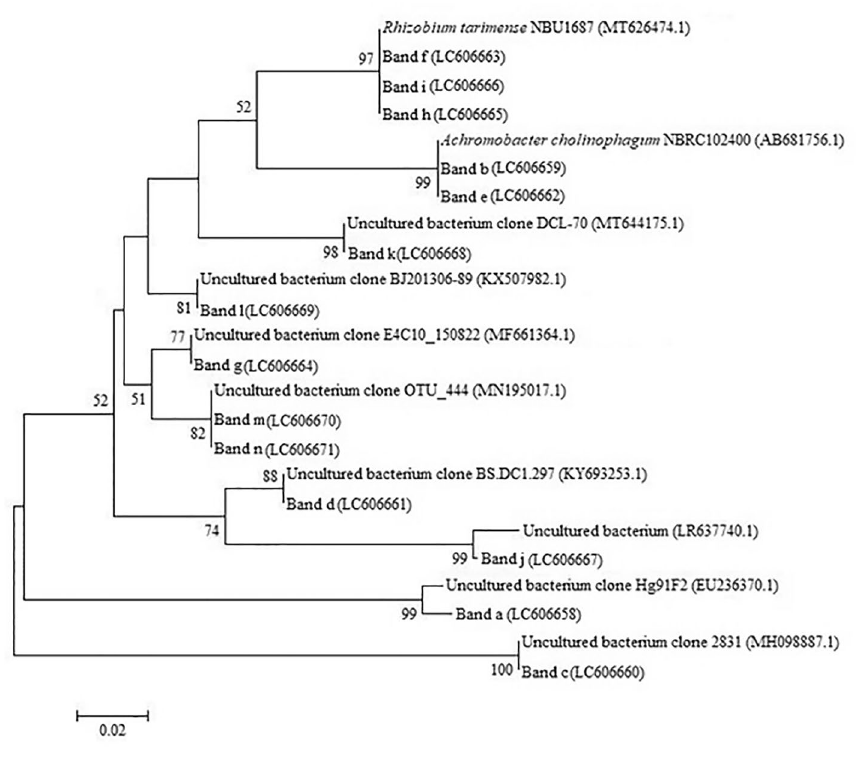
Figure 5. The unrooted phylogenetic tree of 16S rRNA gene sequence with the selective bands presented in the DGGE profile. The tree was conducted using the Neighbor-Joining method. The percentage of bootstrapping values (1000 replicates) are presented on each